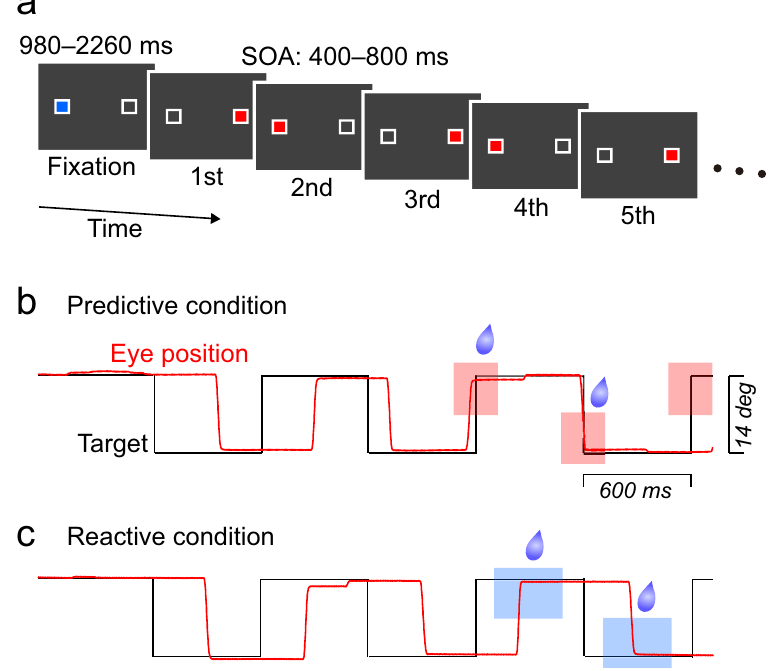
Figure 1. Behavioural paradigm. ( a ) Two unfilled white square landmarks were presented horizontally (14° apart) throughout the trial. A fixation point (blue rectangle) appeared at either landmark location. After a random fixation period, a saccade target (red or green rectangle) was presented at the other landmark. The target alternated with a constant stimulus onset asynchrony (SOA) that was randomly chosen from 400–800 ms (100 ms step; 300, 400, 800 and 900 ms during training sessions, see Methods) in each trial. ( b ) Data from a sample trial with a 600-ms SOA. In the predictive condition, monkeys were rewarded for every predictive saccade that was generated within the specific temporal window ( ± 20% SOA from target onset, pink rectangles). ( c ) In the reactive condition, animals were rewarded for every reactive saccade that was generated > 100 ms from the target onset until 20% SOA before the next target (blue rectangles). Two conditions were presented in separate experimental sessions. Red and green targets were used for the predictive and the reactive conditions,